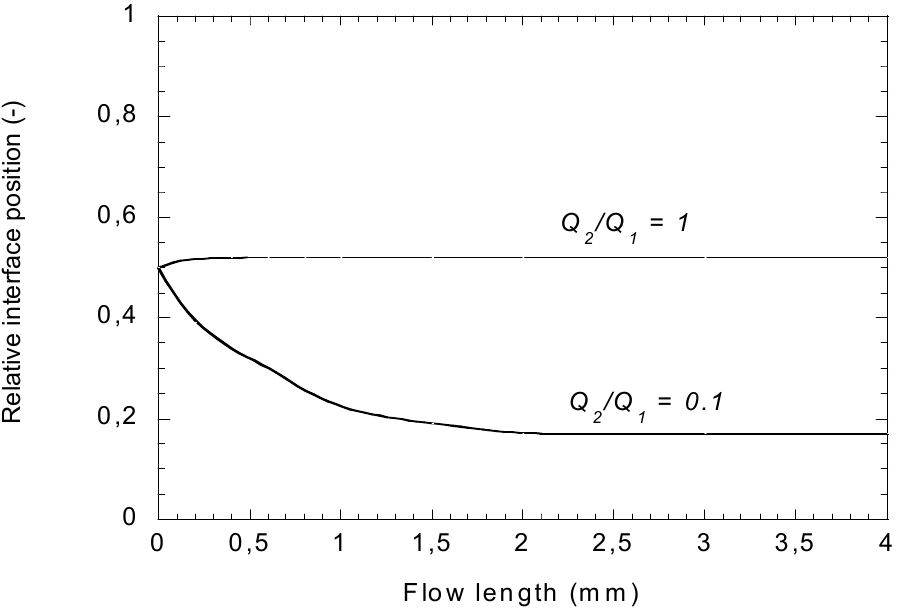
Figure 13. Variation of the interface position in the case of a bilayer flow of two Carreau fluids for two flow rate ratios. The flow rate Q 1 = 2 × 10 − 4 m 3 /s for a die width of 1 m.